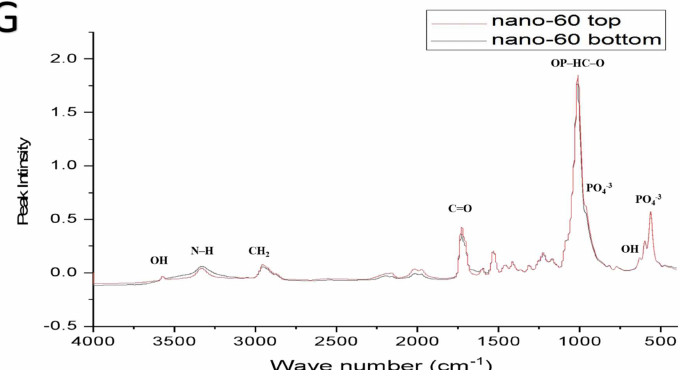
Figure 7. The combined FTIR-ATR spectra of top and bottom of each scaffold; ( A ) PU scaffold has no difference, ( B - D ) PU/HA micro (25, 40 & 60%) scaffolds are different and ( E – G ) PU/HA nano (25, 40 & 60%) scaffolds have almost no difference in peak intensity of OH, PO 4 and CO 2 For PU/HA micro scaffolds, the intensity of OH and PO 4 peaks are significantly higher and, the CO 2 peak is lower in the bottom surface than the top surface, confirming that the majority of HA particles are in the bottom surface (Figure 7B–D). This distribution of HA particles in PU scaffold produces two surfaces, active and nonactive. The (CH 2 –O–CH 2 ) of the ester peak is higher in the top surface compared to the bottom one. However, the case is entirely different with PU/HA nano scaffolds (Figure 7E–G). There is no significant difference in peak intensity of OH, PO 4 and CO 2 between the top and bottom surfaces of PU/HA nano scaffolds. All peaks are almost entirely matched between both surfaces in those scaffolds, especially with PU/HA nano 60% . Those matching of peak intensity could be a sign of dispersed distribution of HA nano particles, due to the high surface area and crystallinity of nanoparticles. This leads to a reduction in the possibility of HA nano particles agglomerating, which provides better stability and combined with PU, generates an equal and better distribution of particles than of microparticles.